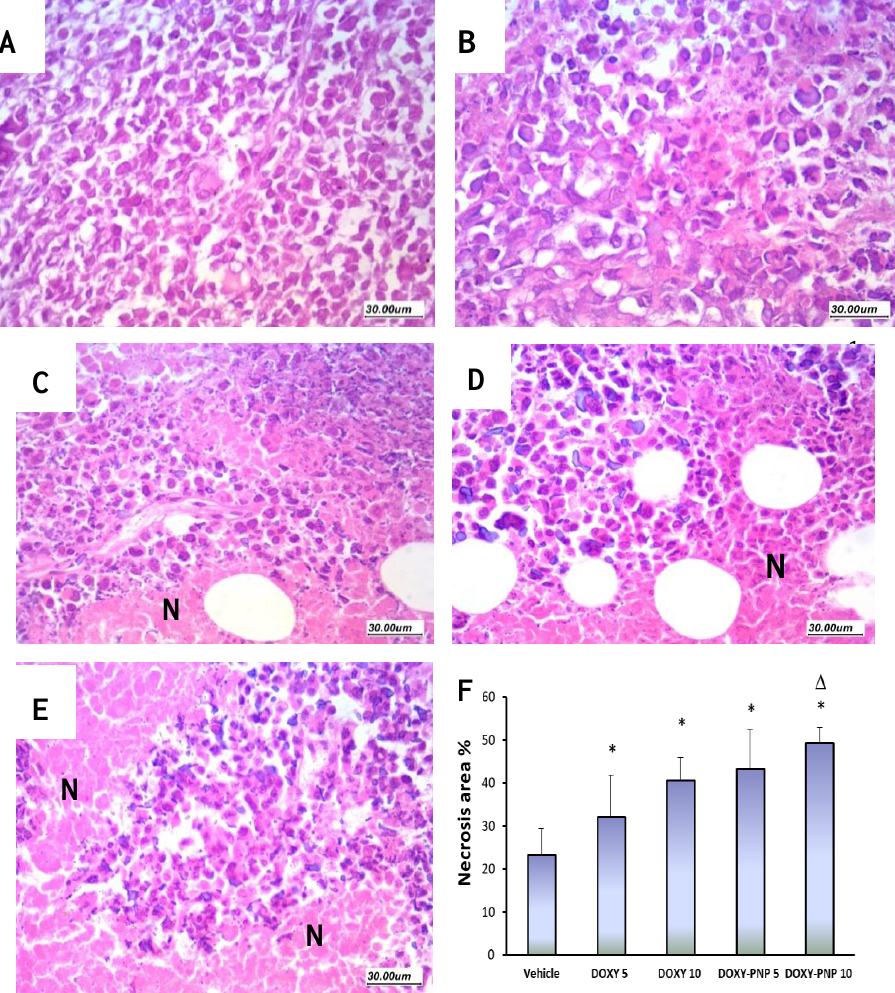
Figure 7. Extent of tumor necrosis in solid Ehrlich tumors. Sections from the solid tumors stained with H&E (×100) showing ( A ) the vehicle group with minimal necrosis within viable tumor tissue, compared to wide areas of tumor necrosis in the groups treated by either free DOXY (5 and 10 mg/kg) ( B , C ) or DOXY-PNP (5 and 10 mg/kg) ( D , E ); N—refers to necrosis area. ( F ) Column chart demonstrating the mean necrotic area ± SD. Data were analyzed using multivariate ANOVA followed by Bonferroni’s post-hoc test at probability value <0.05. *Versus vehicle, Δ versus DOXY 5 mg/kg, Φ versus DOXY 10 mg/kg, δ versus DOXY-PNP 5 mg/kg, n =6.